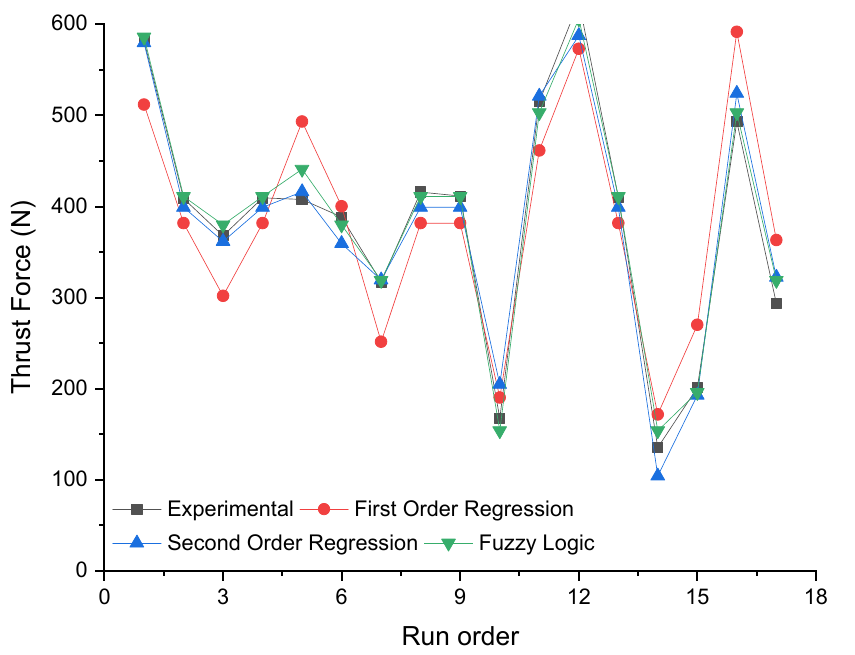
Figure 15. Comparison of experimental and predicted values of thrust force.